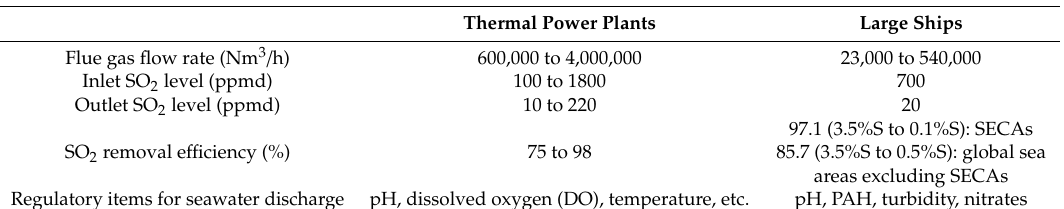
Table 1. Di ff erences in system design conditions of desulfurization processes between thermal power plants and large ships